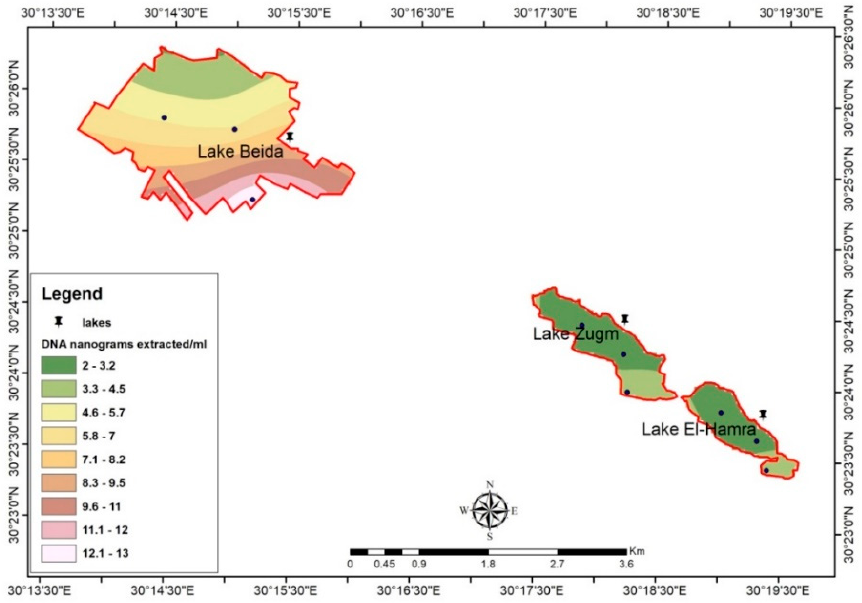
Figure 7. Spatial distribution by GIS of DNA (ng/mL) extracted from water samples of Wadi El- Natrun soda lakes. Note that the El-Fazda lake was dry during the sampling campaign and only contained sediment.